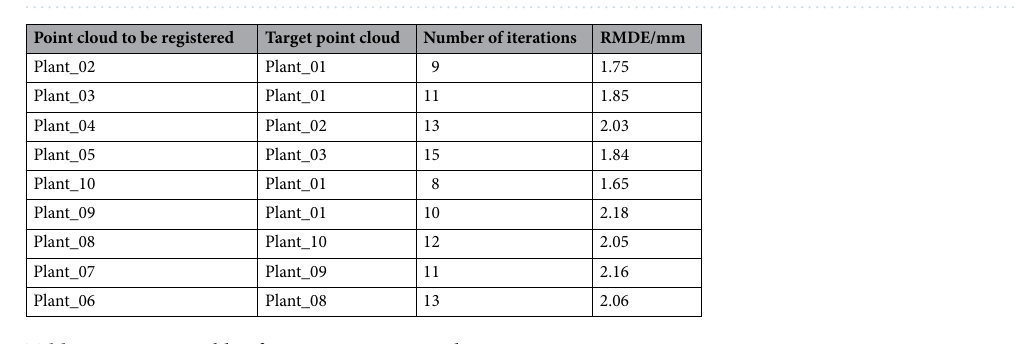
Figure 11. Remove the point clouds of flowerpot.